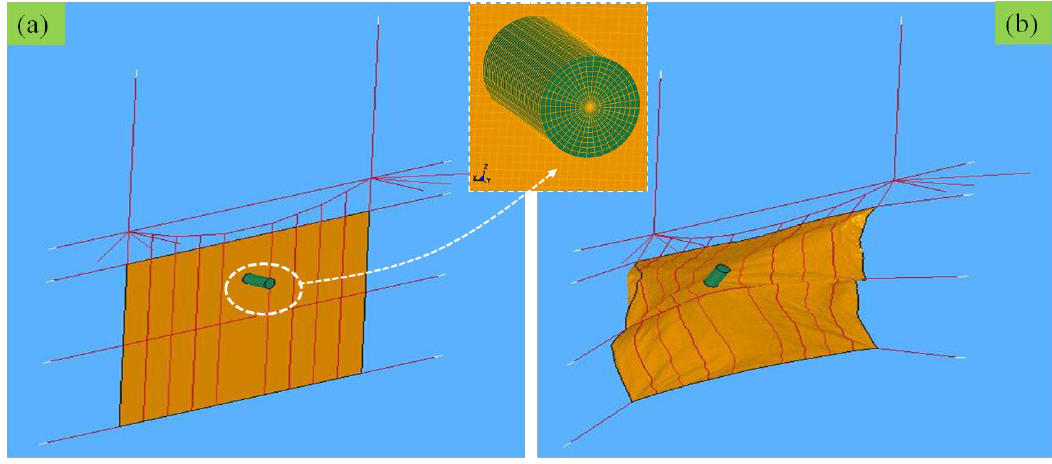
Figure 7. FE model of the R-LPR. (a): Undeformed state. (b): A deformed state 2 Fig. 7. FE model of the R-LPR. (a) : undeformed state. (b) : a deformed state. The intensity of dead load (weight per unit